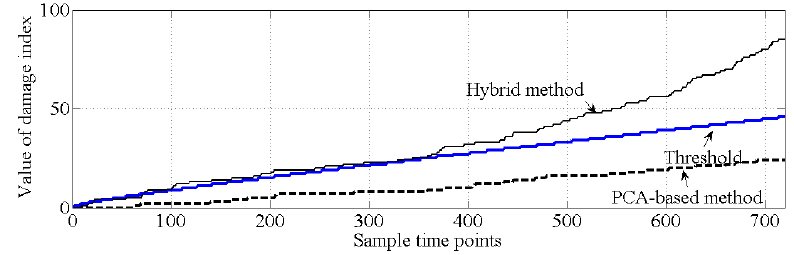
Figure 11. Comparison of the results of damage detection (case 2).